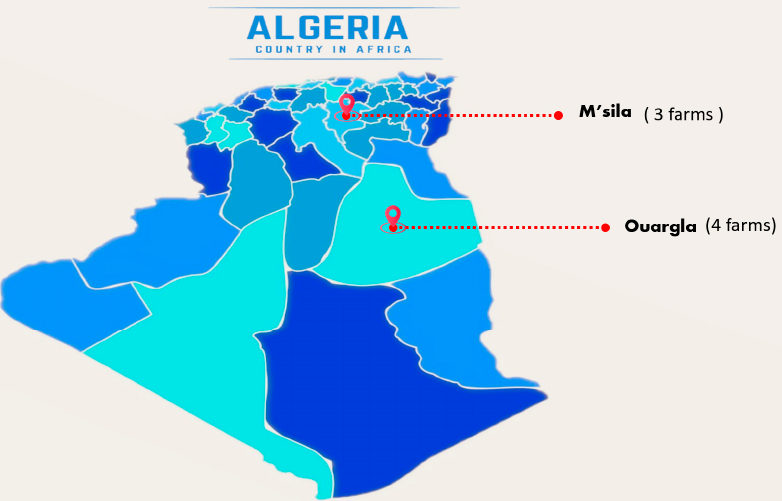
Figure 3. Sample collection sites. (In the centre of Algeria: M’sila, in the south of Algeria: Ouargla).